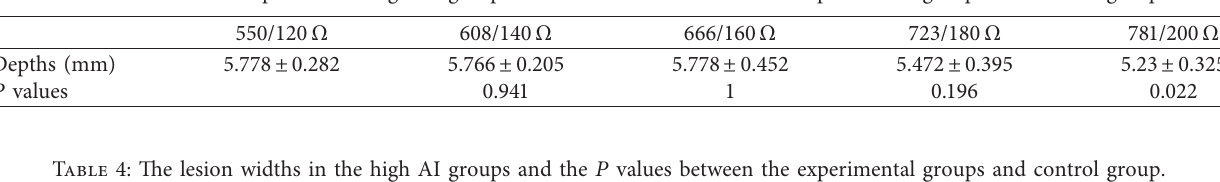
Table 4: The lesion widths in the high AI groups and the P values between the experimental groups and control group. Widths (mm)